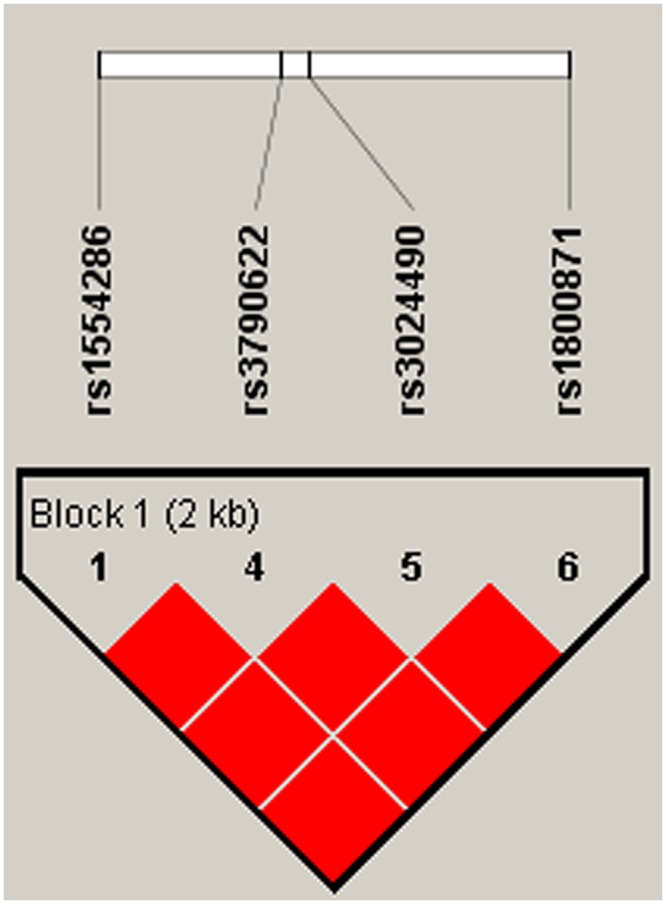
Haplotype block map for part of the (SNPs) in the IL-10 gene.Four SNPs in the haplotype map (rs1554285, rs3790622, rs3024490, and rs1800871) had linkage disequilibrium (LD). A standard color frame is used to show the LD pattern. The D value was 1. These four SNPs tended to be co-inherited.